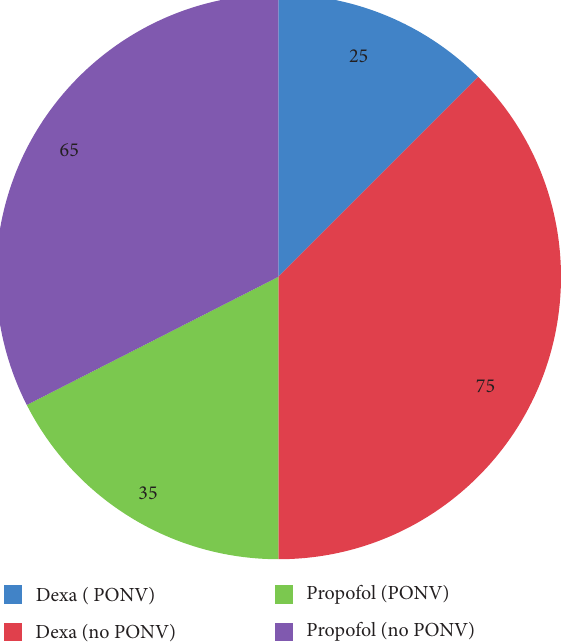
Figure 2: Incidence of PONV (%) from 0 to 24 hours. Dexa: dexamethasone; PONV: postoperative nausea and vomiting.